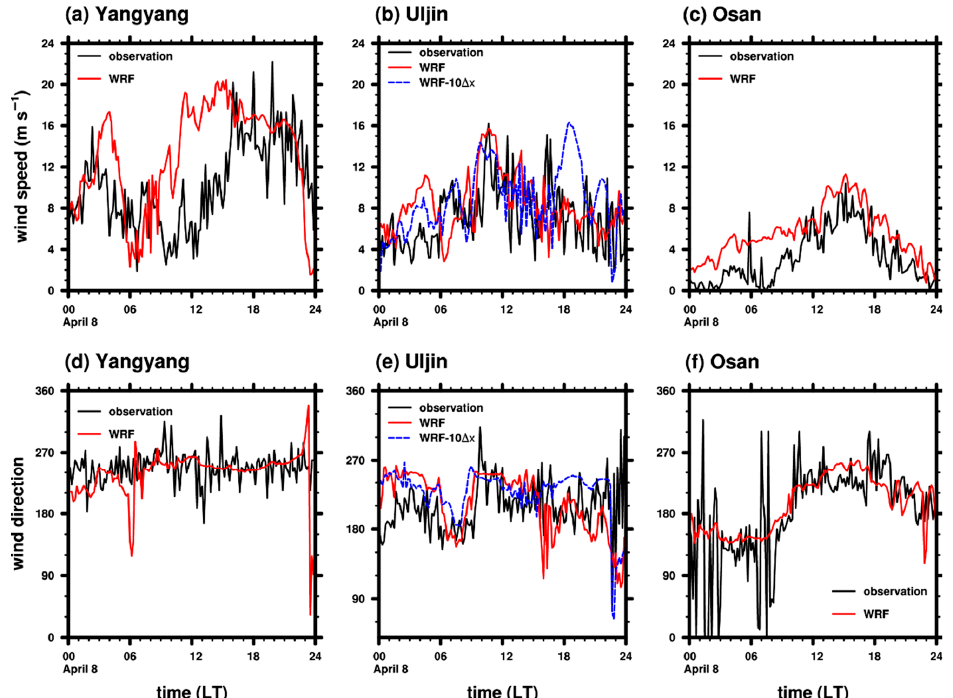
Figure 4. Time series of ( a – c ) the 10-m instantaneous wind speed and ( d – f ) the 10-m instantaneous wind direction at ( a , d ) Yangyang, ( b , e ) Uljin, and ( c , f ) Osan stations. The black and red lines indicate the observed data and simulation results, respectively. The blue dashed line in ( b , e ) indicates the time series of the simulated 10-m wind speed and the wind direction at the location 10 Δ x (3.33 km) west of Uljin station.